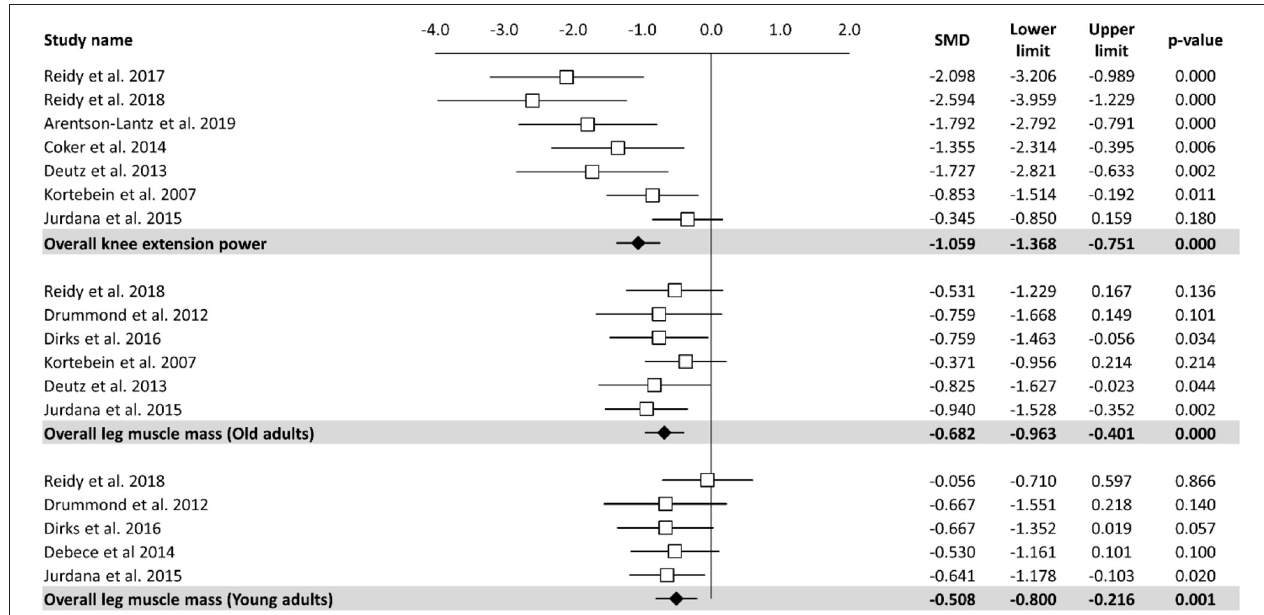
FIGURE 3 | Effects of bed rest on skeletal muscle performance. The results are displayed separately for knee extension power, leg muscle mass in old adults and muscle mass in young adults and data expressed as percent differences from the baseline. Mean values and 95% CI are reported for each study as squares and thin lines, respectively. Summary results for each investigated parameter are described as solid diamond and thin lines on the gray background. The figures, with P -values, are reported on the right part of the plot.